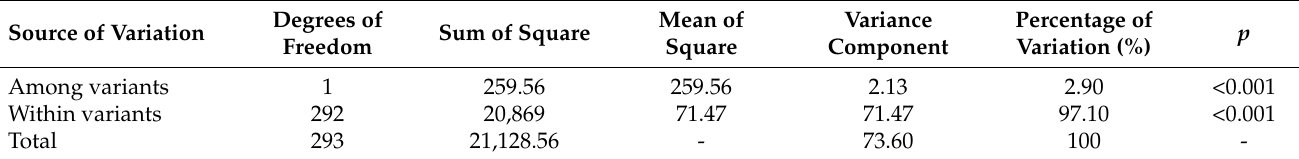
Table 3. AMOVA analysis of different variant populations.